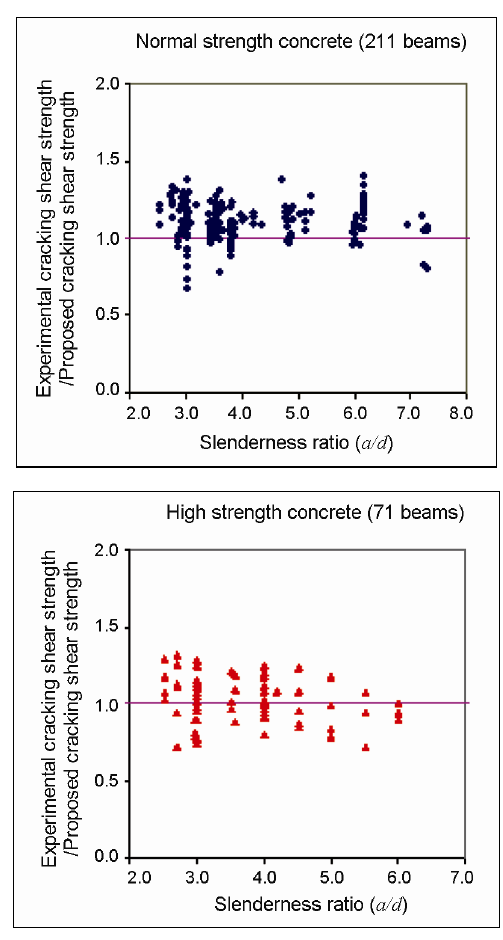
Fig. 4. Comparing experimental cracking shear strength values with proposed diagonal cracking strength of Eq. (12) for various slenderness